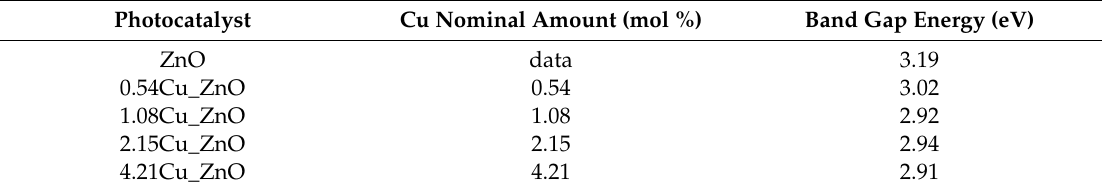
Table 1. List of the prepared samples with the nominal Cu loading and band gap